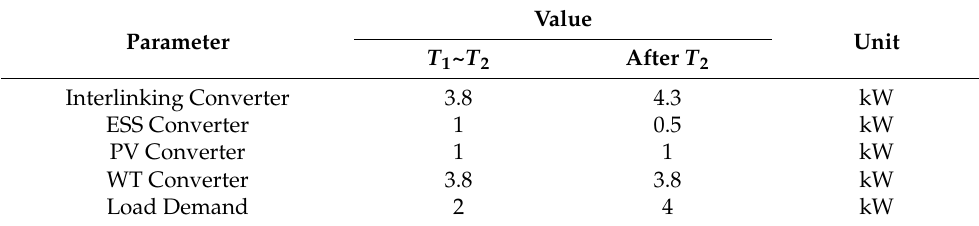
Table 5. Power flow of each power converter in operation mode